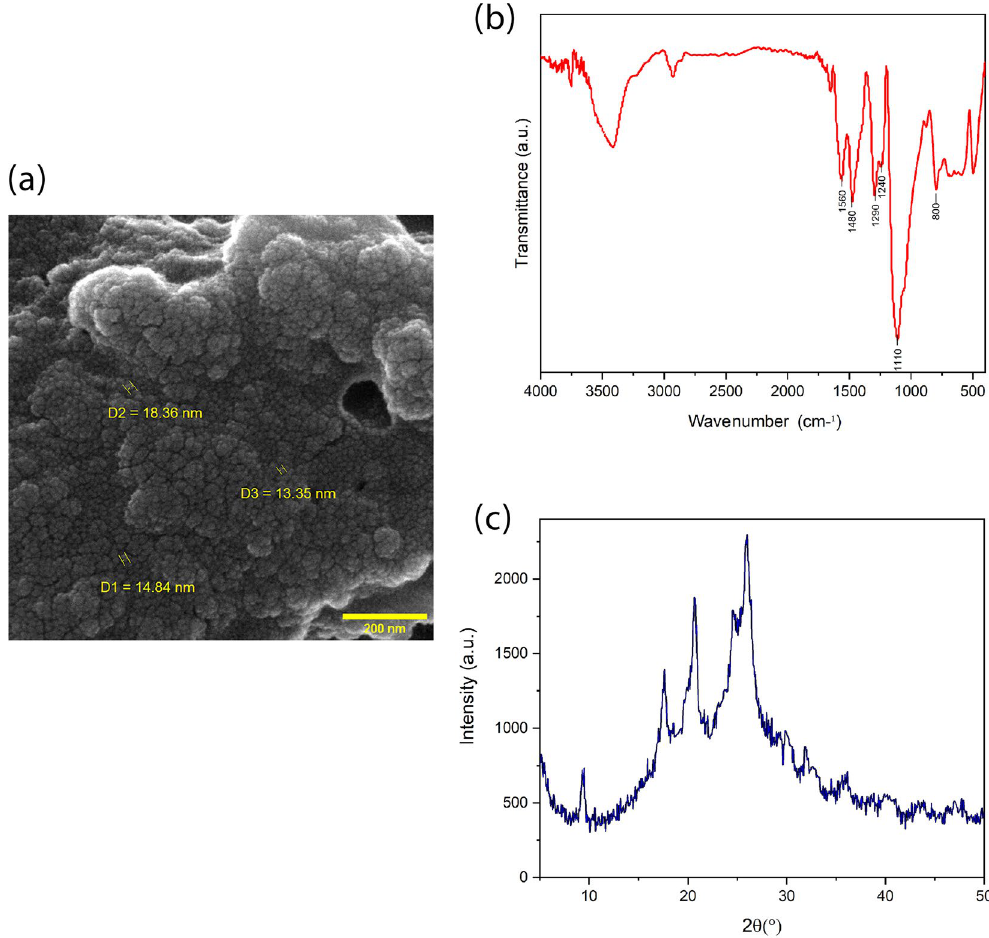
Figure 1. Analysis of synthesized PANI nanoparticles: ( a ) FE-SEM micrograph of synthesized PANI nanoparticles, which represents the spherical uniform distribution with an average diameter of 15 ± 2 nm, ( b ) FTIR spectra shows that the band near 1560 cm −1 and 1480 cm −1 related to C=C stretching deformation of Benzenoid and Quinoid rings, while the band absorbed at 1110 cm −1 pointed to the aromatic C–H in plane bonding. Also, the C–N stretching of the secondary amine of the PANI backbone is characterized by the peak at 1290 cm −1 . ( c ) XRD pattern shows that all four major characteristic peaks with 2θ values are represented at 25.85°, 20.65°, 17.65°, and 9.5°. The sharp and well-defined peaks in the X-ray pattern indicated formation of a semi-crystalline structure of PANI NPs due to the Benzenoid and Quinoid functional